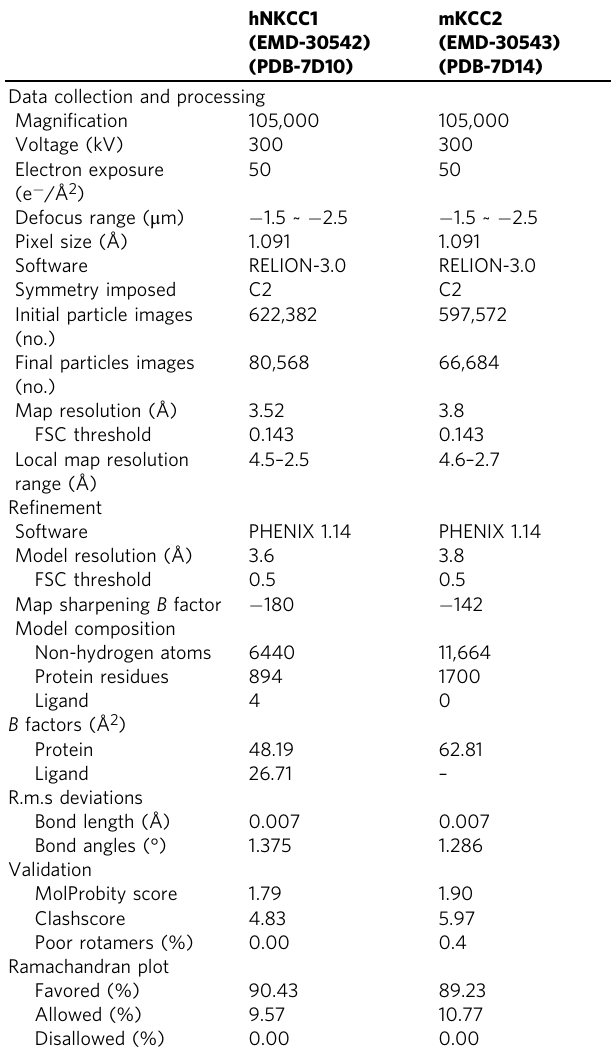
Table 1 Cryo-EM data collection, re fi nement, and validation